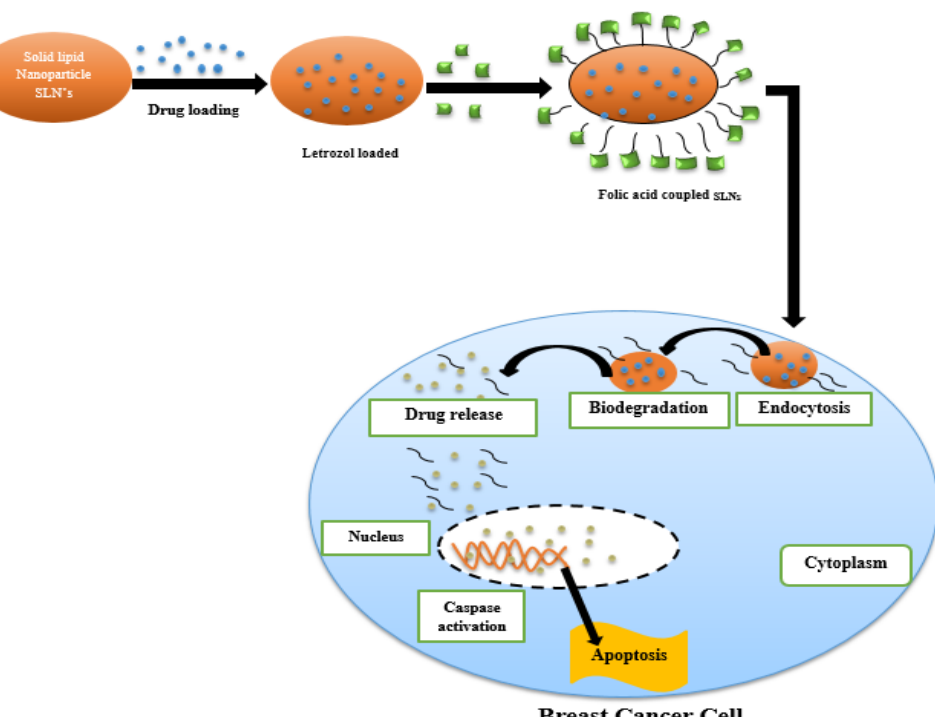
Figure 4. Schematic representation of mechanism of drug letrozol loaded on solid lipid nanoparticles (SLNs) and folic acid coupled to SLNs. The whole carrier was delivered inside the animal rat model to treat effects on breast cancer cell lines. Inside cytoplasm, biodegradation occurred, as well as drug release and caspases ’ activation inside nucleus, causing apoptosis.